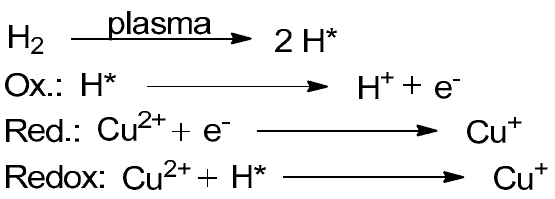
Figure 13. Redox equations of the elemental processes during the plasma reduction of the copper salt layer with the specific oxidation and reduction equations in the second and third line. The first line shows the plasma-induced dissociation of molecular hydrogen to excited atomic hydrogen (H*) and the last stands for the complete redox process.